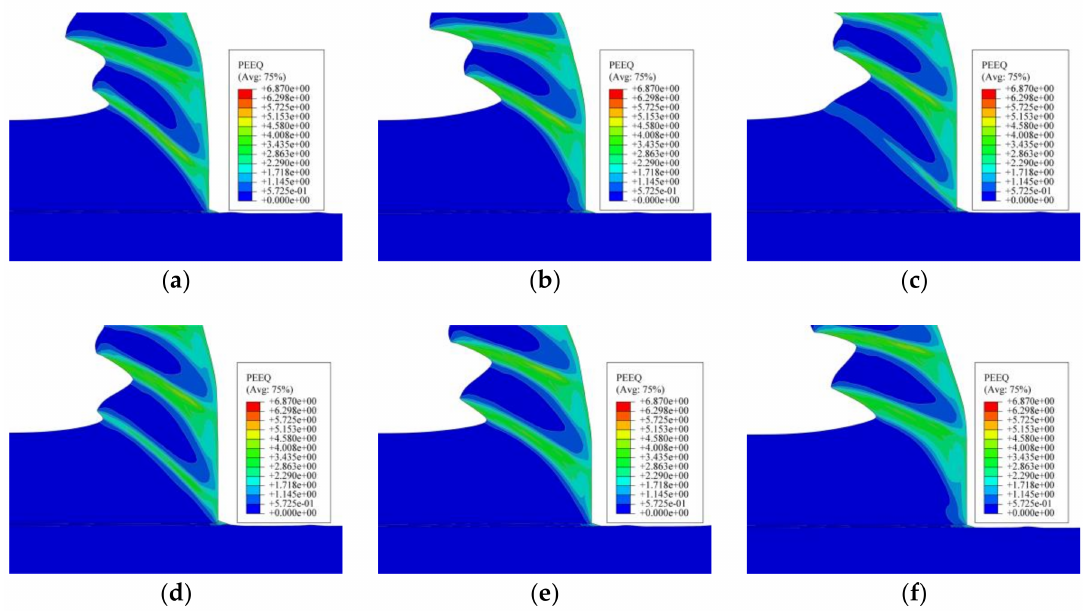
Figure 13. Chip formation process and the equivalent plastic strain under condition of v s = 450 m/min, f r = 0.2 mm/r: ( a ) the fully formed saw-tooth segments; ( b ) the new segment began to form; ( c ) the development of the shear plane; ( d ) adiabatic shear instability in the shear plane; ( e ) shearing slip of the chip material; and ( f ) the new saw-tooth segment was fully